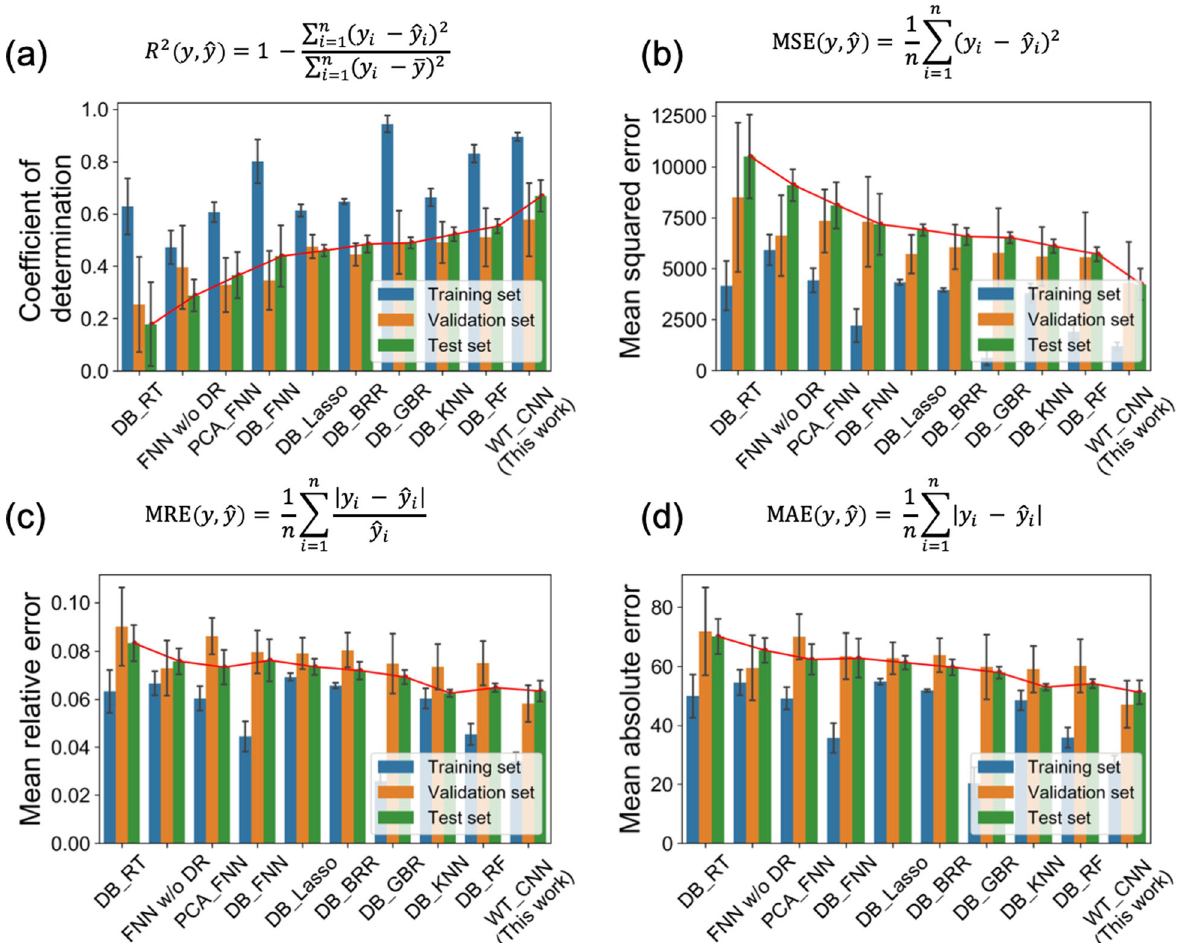
Fig. 10 Comparisons of ten candidate models with four metrics. The error bars indicate the standard deviations of the fi ve model results based on 5-fold cross-validation. Name of a model includes two parts separated by an underline. The fi rst part indicates the method used for reducing the dimension of the input (thermal history). The method includes Discrete Binning (DB) ( “ Dimension reduction by Discrete Binning (DB) ” section), PCA, and WT ( “ Wavelet transform ” section). The second part indicates the regression method including Regression Tree (RT) 33 , Feed-forward Neural Network (FNN) 57 , Lasso 58 , Bayesian Ridge Regression (BRR) 59 , Gradient Boosting Regression (GBR) 34 , K-Nearest Neighbors (KNN) 60 , Random Forest (RF) 33,61 , and CNN 62 . a Coef fi cient of determination ( R 2 ), b mean squared error (MSE), c mean relative error (MRE), d mean absolute error